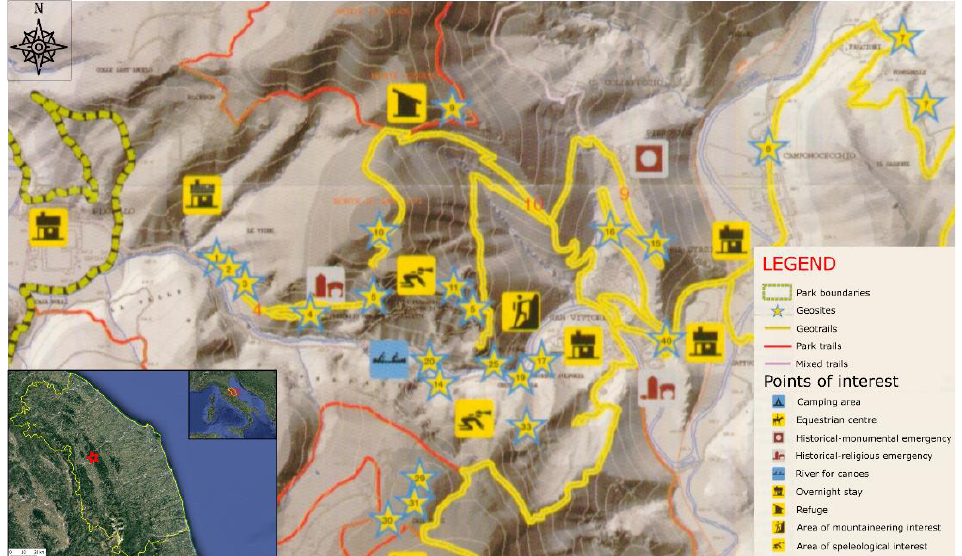
Figure 1. An excerpt of the map attached in “I Quaderni del Parco, N.8—Geositi e Geoescursionismo nel Parco Naturale della Gola della Rossa e di Frasassi” [1], with the geosites and historical/cultural places indicated along the Frasassi gorge (the red star in the overview map indicates its location). The coordinate grid and the scale bar are shown in the original map.